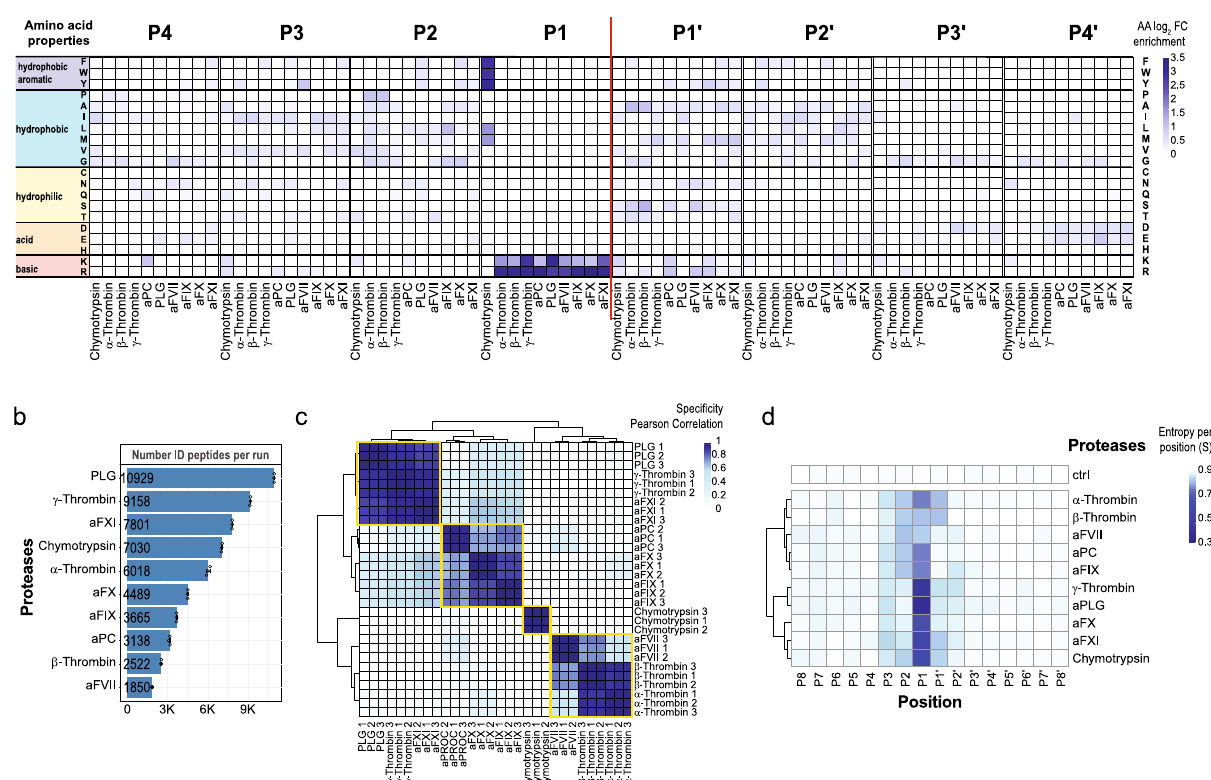
Fig. 3 High-throughput screening of coagulation proteases. a Positional substrate preferences of coagulation proteases from the chymotrypsin-like family (Chymotrypsin, activated α -, β -, γ -Thrombin, aFVII, aFIX, aFX, aFXI, aPC and PLG). The heat map includes positions P4-P4 ’ . The AAs are grouped according to their physicochemical properties. The enrichments are reported as log 2 FC compared to a random AA distribution generated from HTPS database. b Peptides generated by the coagulation proteases included in the study; each protease is characterized by the average number of peptides identi fi ed from three independent replicate experiments ( n = 3). Data are presented as mean values±SD. c Unsupervised hierarchical cluster of coagulation proteases. The color scale describes the Pearson correlation coef fi cient value calculated for the respective protease samples. d Unsupervised hierarchical cluster of coagulation proteases according to the positional cleavage entropy. The color scale describes the cleavage entropy (S) values for positions P8-P8 ’ for all respective proteases included in the assay. Source data are provided as a Source Data fi